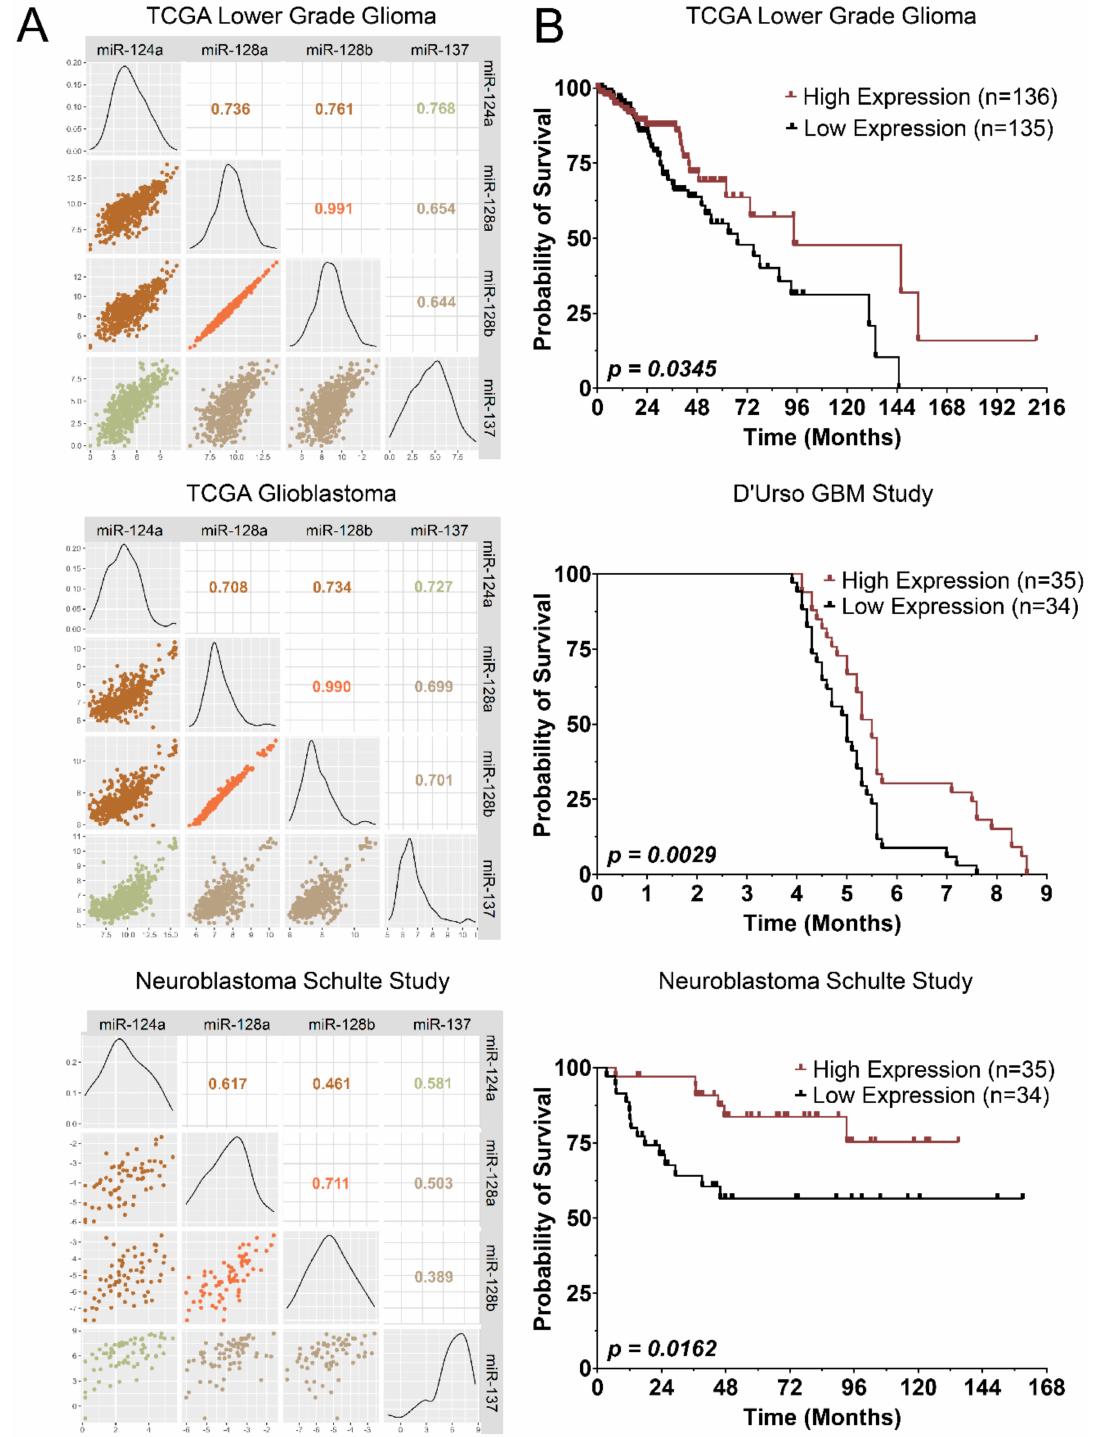
Figure 2. miR-124, miR-128, and miR137 coexpression in glioma and neuroblastoma patients and impact on patient survival. ( A ) miRNA expression correlation in patient samples from the The Cancer Genome Atlas Low Grade Glioma (TCGA LGG), The Cancer Genome Atlas Glioblastoma Multiforme (TCGA GBM), and in neuroblastoma (Schulte study). Upper right panels display Pearson correlation coefficient between the miRNAs. Middle panels display distribution of miRNA expression. Lower left panels display miRNA expression scatterplots. ( B ) Survival rates of patients expressing low vs. high miR-124, -128, and -137 in TCGA LGG, D’Urso GBM Study, and Schulte Neuroblastoma